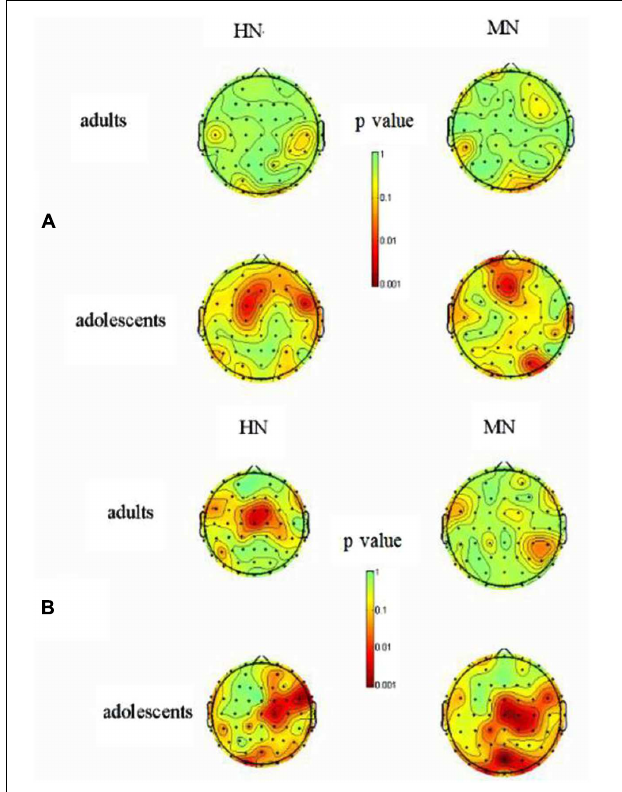
FIGURE 5 | (A) The scalp distribution of the emotion effect on theta for HN and MN stimuli in 500–600 ms (red color denotes smaller p value and stronger significance level); (B) The scalp distribution of the emotion effect on beta for HN and MN stimuli in 500–600 ms (red color denotes smaller p value and stronger significance